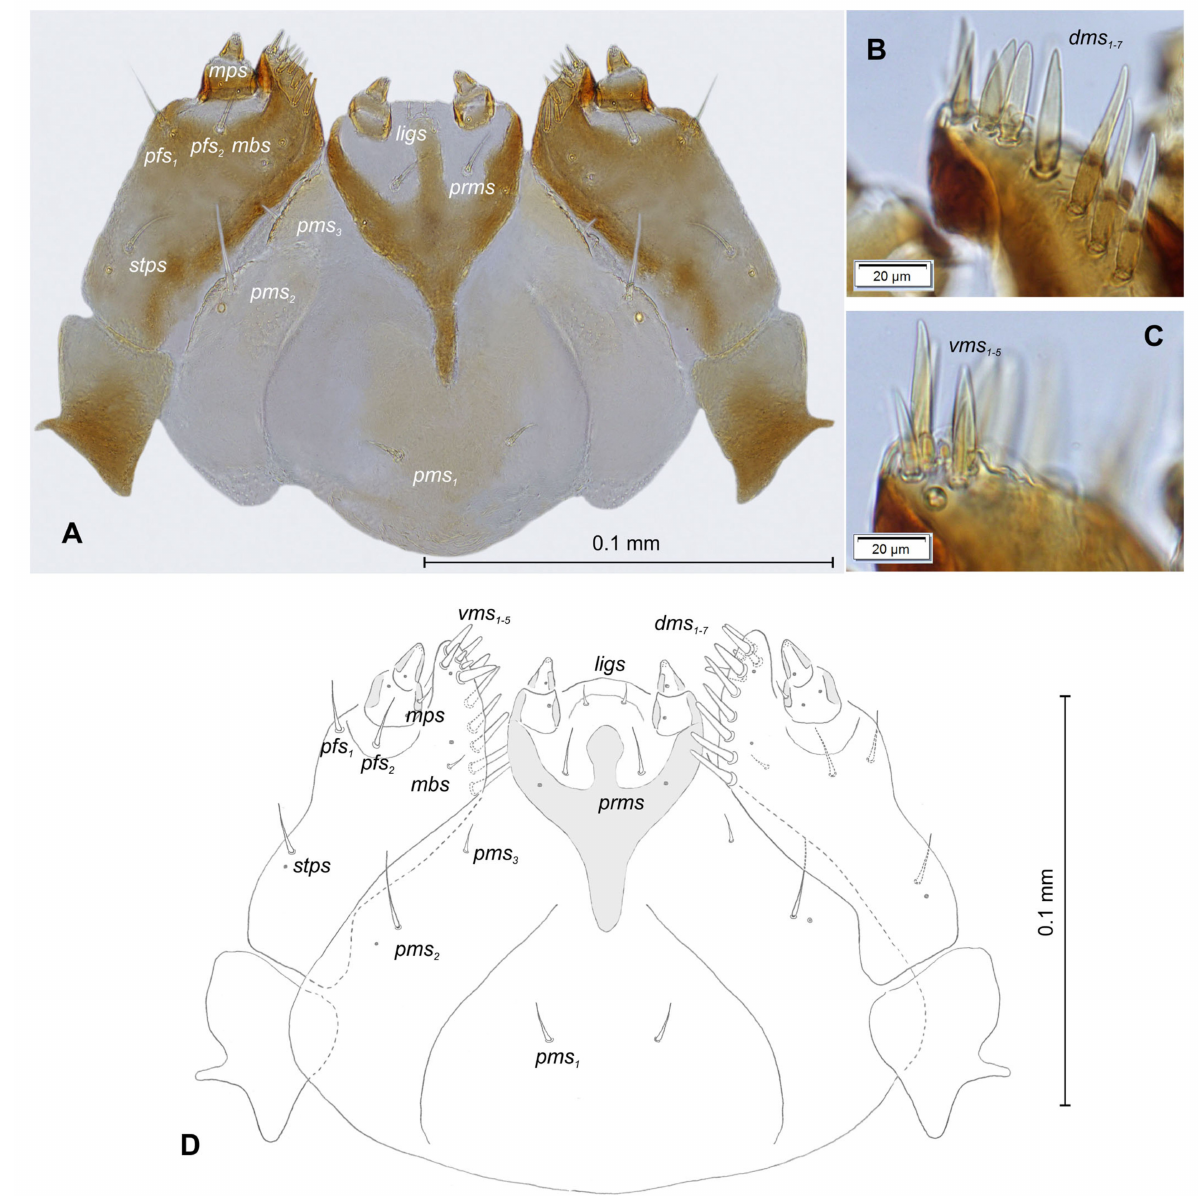
Figure 17. Rhinocyllus alpinus mature larva, maxillolabial complex. ( A )—maxillolabial complex, ventral aspect, photo; ( B )—maxillolabial complex, ventral aspect, scheme; ( C )—apical part of right maxilla, dorsal aspect; ( D )—apical part of right maxilla, ventral aspect; (setae: dms —dorsal malar, ligs —ligular, mbs —malar basiventral, mps —maxillary palp, pfs —palpiferal, prms —prelabial, pms —postlabial, stps —stipal, vms —ventral